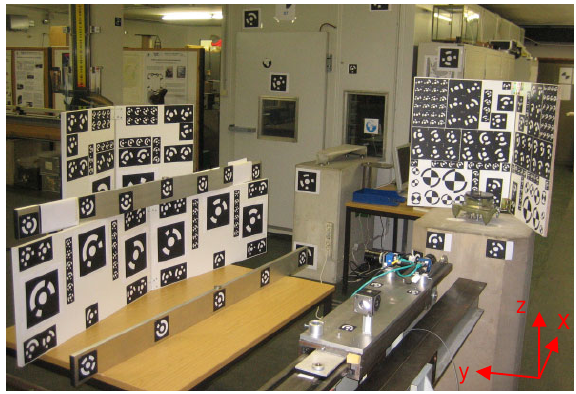
Figure 5. Reference targets in scenario (II)